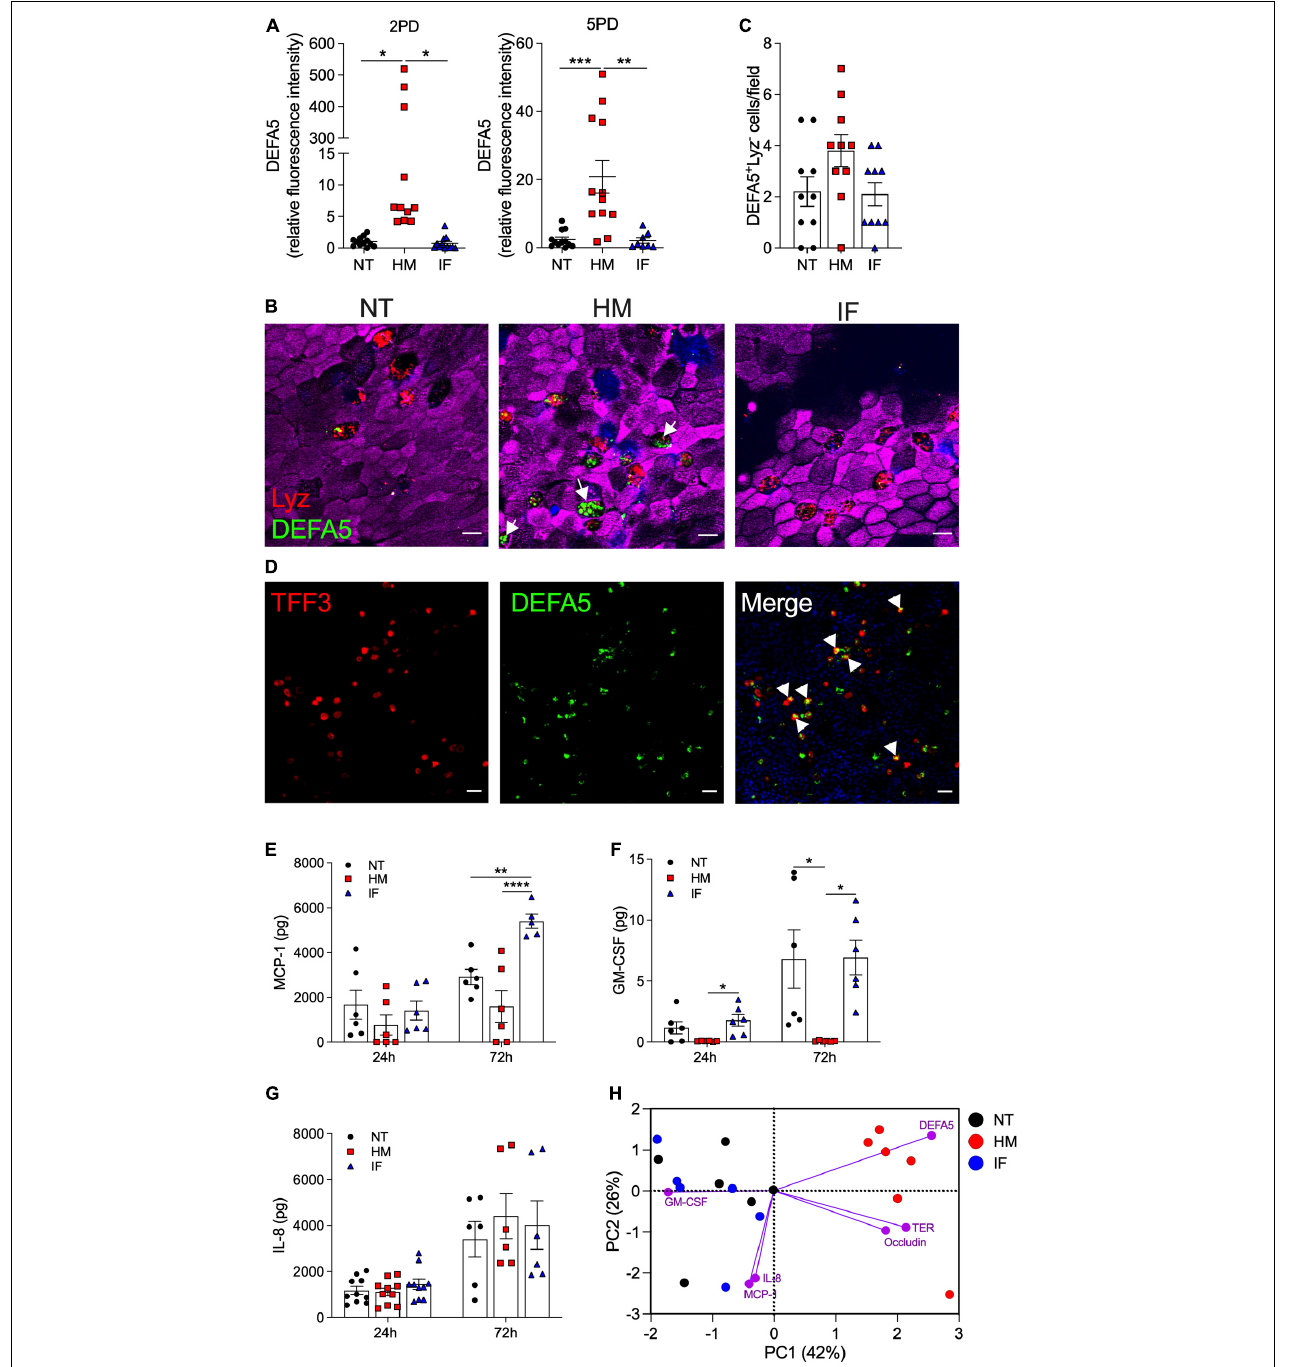
FIGURE 4 | Human milk modulates epithelial innate immune function. (A) Relative fluorescence intensity of human DEFA5 quantified by confocal microscopy analysis of 2PD and 5PD monolayers NT or treated with HM (20%; v/v) or IF (20%; w/v) for 48 h. (B) Representative confocal microscopy images (XY projections) of 5PD monolayer showing localization (arrowheads) of DEFA5 in Lyz-negative cells in HM-treated monolayer and (C) number of Lyz-negative cells quantified by immunofluorescent confocal microscopy ( ≥ 6 different view fields). DEFA5, green; Lyz, red; actin, magenta; DNA, blue. Scale bar = 10 µ m. (D) Representative confocal microscopy images (XY projections) of 5PD monolayer depicting co-localization (arrowheads) of TFF3 (red) and DEFA5 (green); DNA, blue. Scale bar = 50 µ m. (E–G) Total amount of MCP-1, GM-CSF, and IL-8 in the apical media of 2PD monolayer treated with HM and IF as described in panel (A) for 24 and 72 h. (H) PCA plot from HM- and IF-treated monolayers, and NT controls for 24 h. PC, principal component. Variables analyzed: TER, occludin, DEFA5, MCP-1, GM-CSF, and IL-8. (A,C,E–G) Mean ± SEM are shown. Data are representative of three independent experiments with n = 6–12 enteroid monolayers/group per experiment. Each symbol indicates an independent monolayer. p -values were calculated by one-way ANOVA with Tukey’s post-test for multiple comparisons. * P < 0.05; ** P < 0.01; *** P < 0.001; **** P < 0.0001.